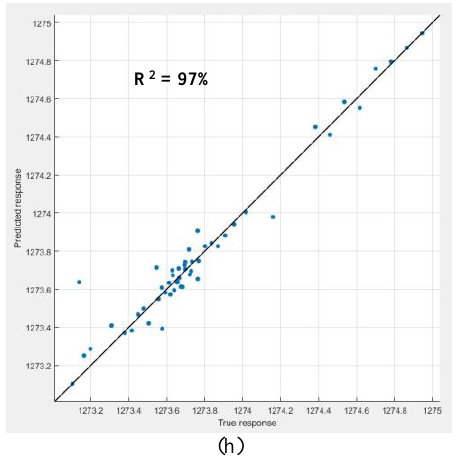
Figure 8. Correlation between retrieved and observed water